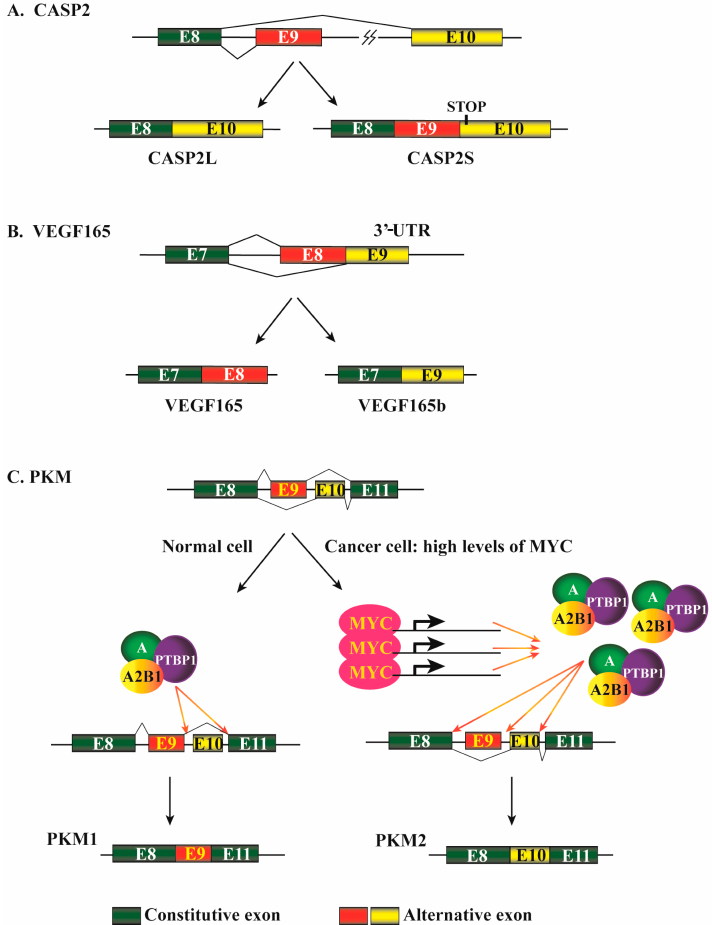
Figure 3. Alternative pre-mRNA splicing events of representative genes. ( A ) Cassette exons mechanism of alternative CASP2 pre-mRNA splicing. Constitutively expressed exons are depicted in green boxes, and alternatively spliced exons are in red or yellow boxes. Introns are represented by black lines with an omitted region indicated by a lightening sign. (These are the same in “B” and “C” below). The skipping of exon 9 leads to the formation of a CASP2 mRNA encoding a long version protein, CASP2L. Alternatively, exon 9 can be included in the mature mRNA that encodes a short version of the protein, CASP2S, due to the presence of a premature termination codon in exon 10; ( B ) Alternative 3 (cid:48) splice site mechanism of alternative VEGF165 pre-mRNA splicing. In this mechanism, the 3 (cid:48) end of exon 7 can be alternatively ligated to different sites of the 3 (cid:48) -UTR to form transcripts VEGF165 and VEGF165b, encoding proteins with distinct C-terminals; ( C ) Mutually exclusive mechanism of alternative PKM pre-mRNA splicing. In normal cells, exon 9 is typically retained while exon 10 is excluded. In cancer cells, the highly expressed MYC protein enhances the expression of HNRNPA , HNRNPA2B1 , and PTBP1 genes, which in turn promote an alternative splicing with exon 9 exclusion and exon 10